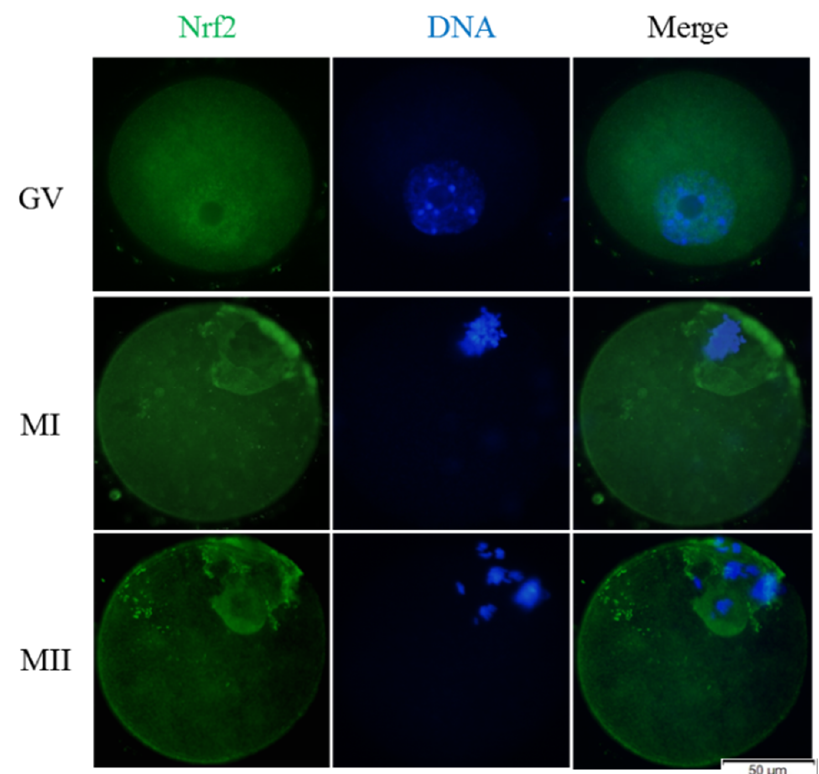
Figure 7. Cellular distribution of Nrf2 during oocyte meiosis. (A) Immunofluorescence staining for the subcellular localization of Nrf2 (green, Nrf2; blue, chromatin). In total 30 oocytes were examined for each group. Scale bar = 50 µm. Notes: GV: germinal vesicle, MI: metaphase I, MII: metaphase II.